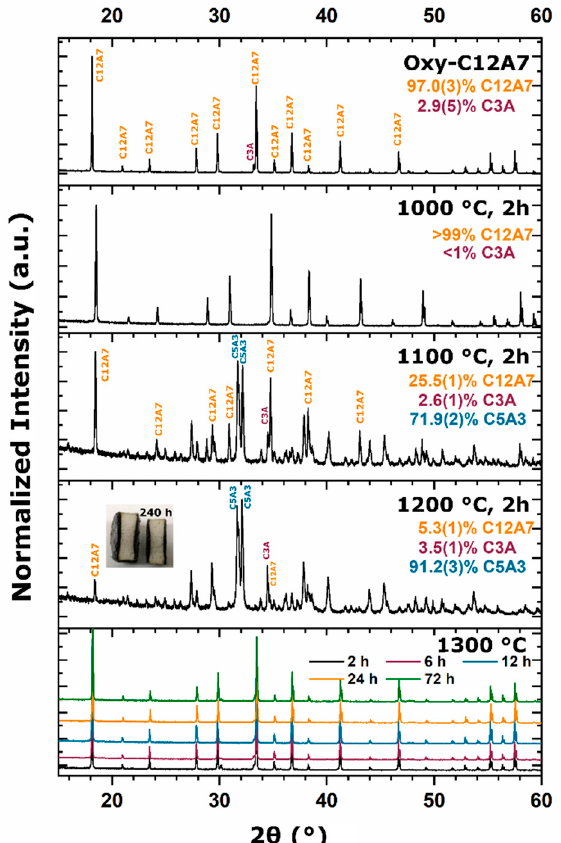
Figure 5 . XRD data plotted as a function of processing temperature and at 1300 °C as a function of time. Refined phase fractions are inset on the XRD patterns. Main C12A7 and secondary phase peaks are identified.